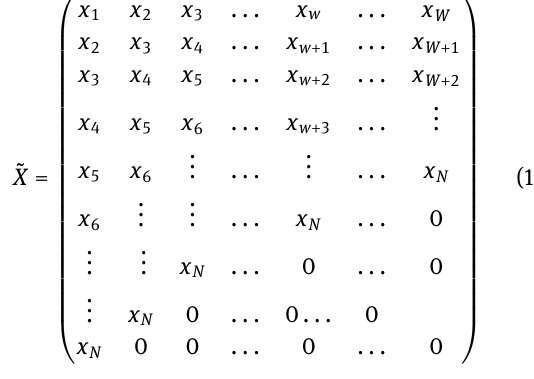
Embedding Given a window with length W (1 < W ≤ N lagged vectors arranged in columns are used to define the trajectory matrix ˜ X . These vectors are padded with zeros to keep the same vector length as is shown in Equation 1.